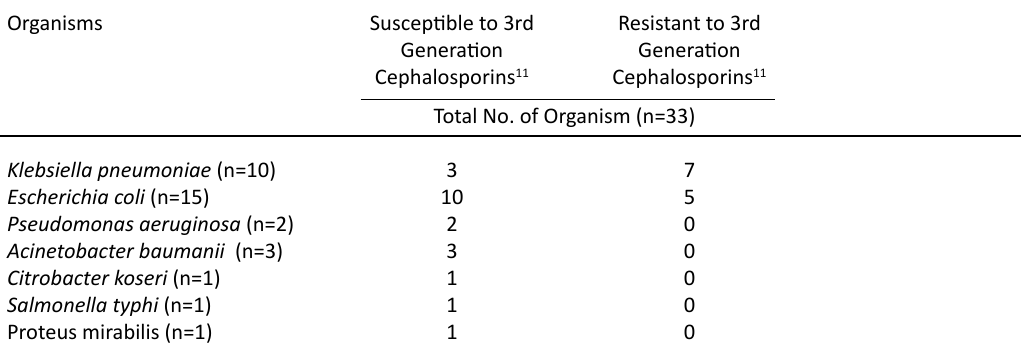
Table 3. Gram negative bacilli profile & their Susceptibility pattern to 3rd generation cephalosporins